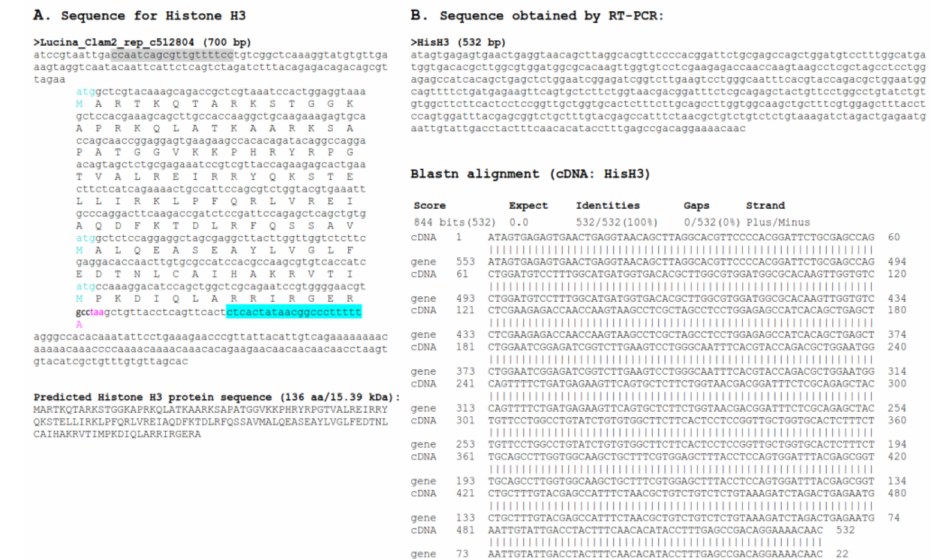
Figure 7. Histone H3 sequence found in Lucina pectinata genome assembly. ( A ) The H3 nucleotide sequence obtained from the BLASTN searches against the L. pectinata genome assembly using the H3 nucleotide sequences from S. marginatus and the partial coding region sequence of H3 from L. pectinata is shown with the ORF translation, the predicted protein sequence and its molecular weight (MW). ( B ) The sequence obtained by Sanger sequencing of RT-PCR products by the BLASTN alignment to the genomic sequence, showing a perfect match between the two sequences. Primers used in RT-PCR are highlighted in cyan and grey. Start (cyan) and stop (pink) codons are indicated.